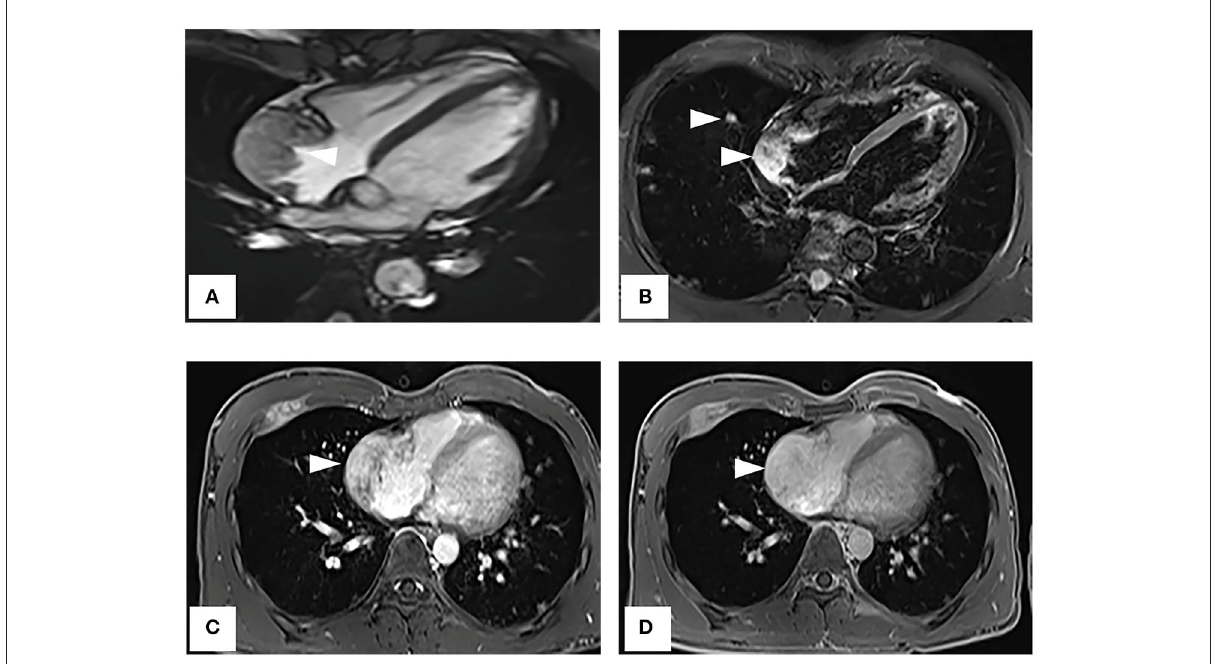
FIGURE2 Cardiac magnetic resonance imaging. (A) On SSFP cine imaging planned in the four chambers, the tumor shows isointense (arrowhead). (B) On T2-short tau inversion recovery sequence images, the tumor displays high-signal intensity (arrowhead). (C,D) On enhanced MR imaging, the tumor shows arterial heterogeneous enhancement and progressive but incomplete enhancement in the delayed phase (dynamic